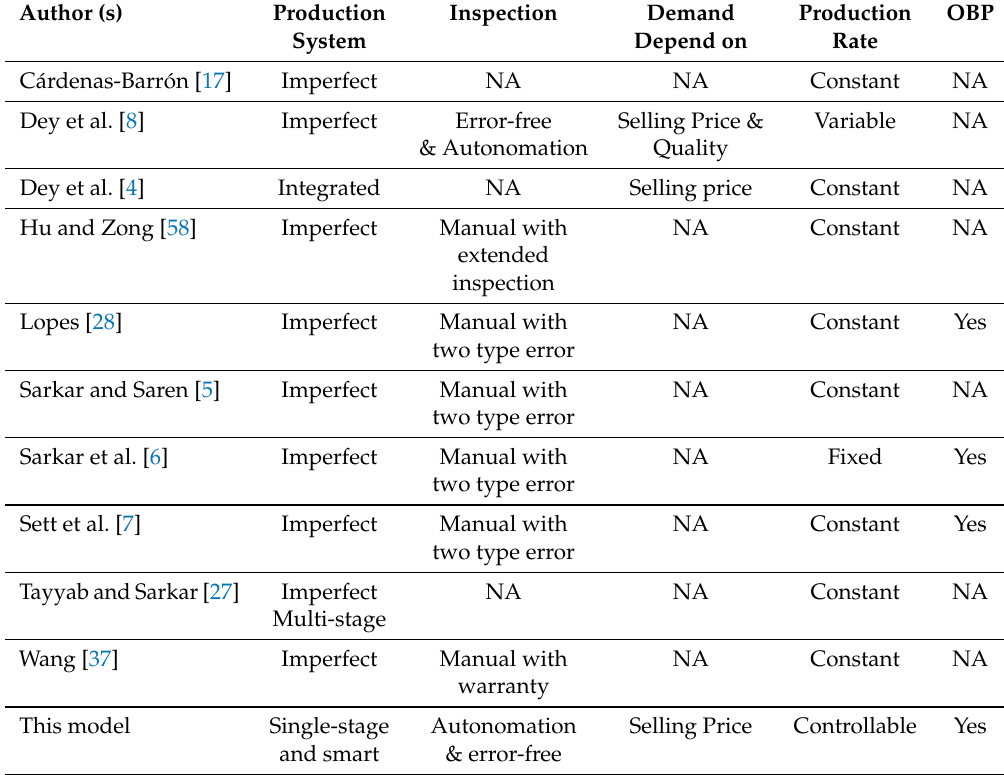
Table 1. Contribution of previous